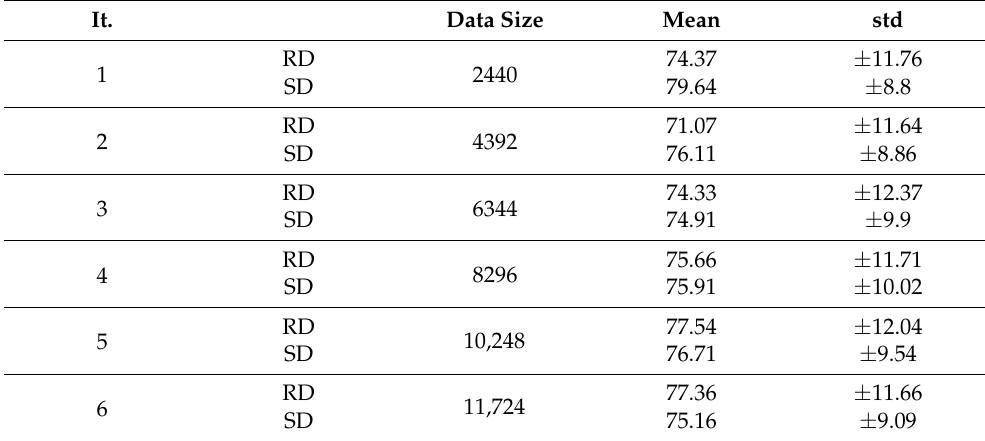
Table 2. Mean and Standard Deviation Values of Heart Rate Measurements for RD and SD.